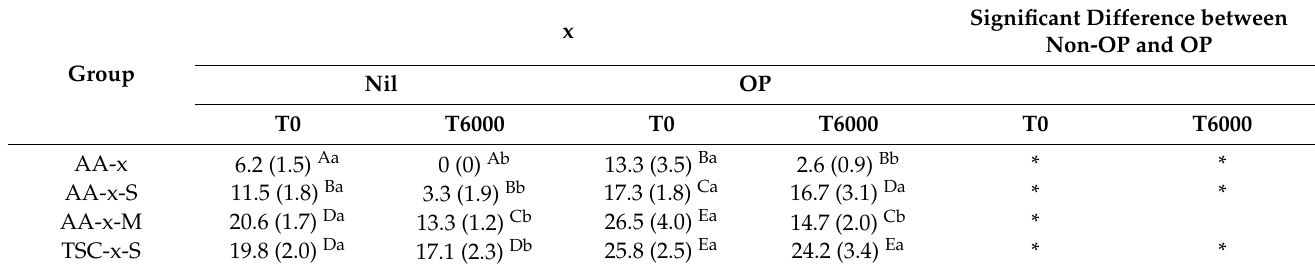
Table 3. The mean (standard deviation) SBS values.